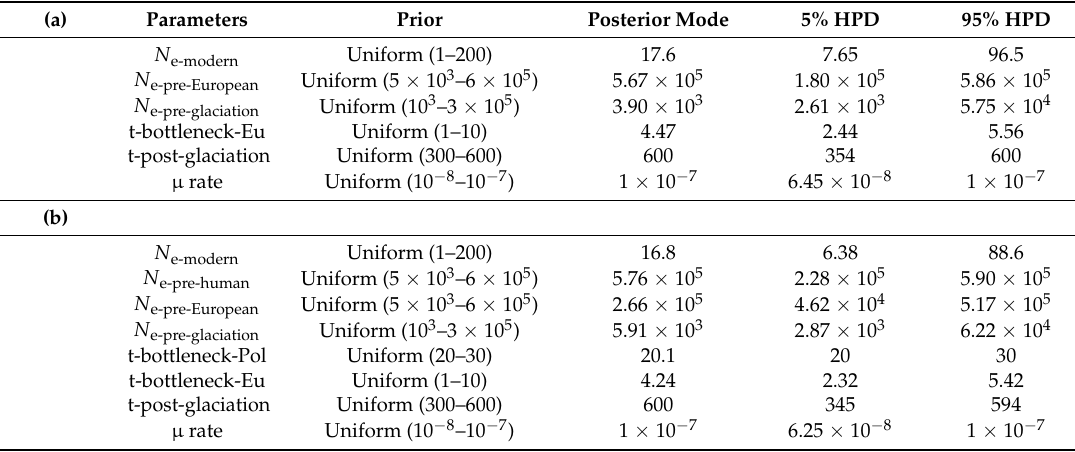
Table 2. Prior and posterior distributions of parameters for refined models of (a) ‘European bottleneck’ and (b) ‘European and Polynesian bottlenecks’. Timing of events corresponds to number of generations and assumes a k¯ak¯ap¯o generation time of 25 years